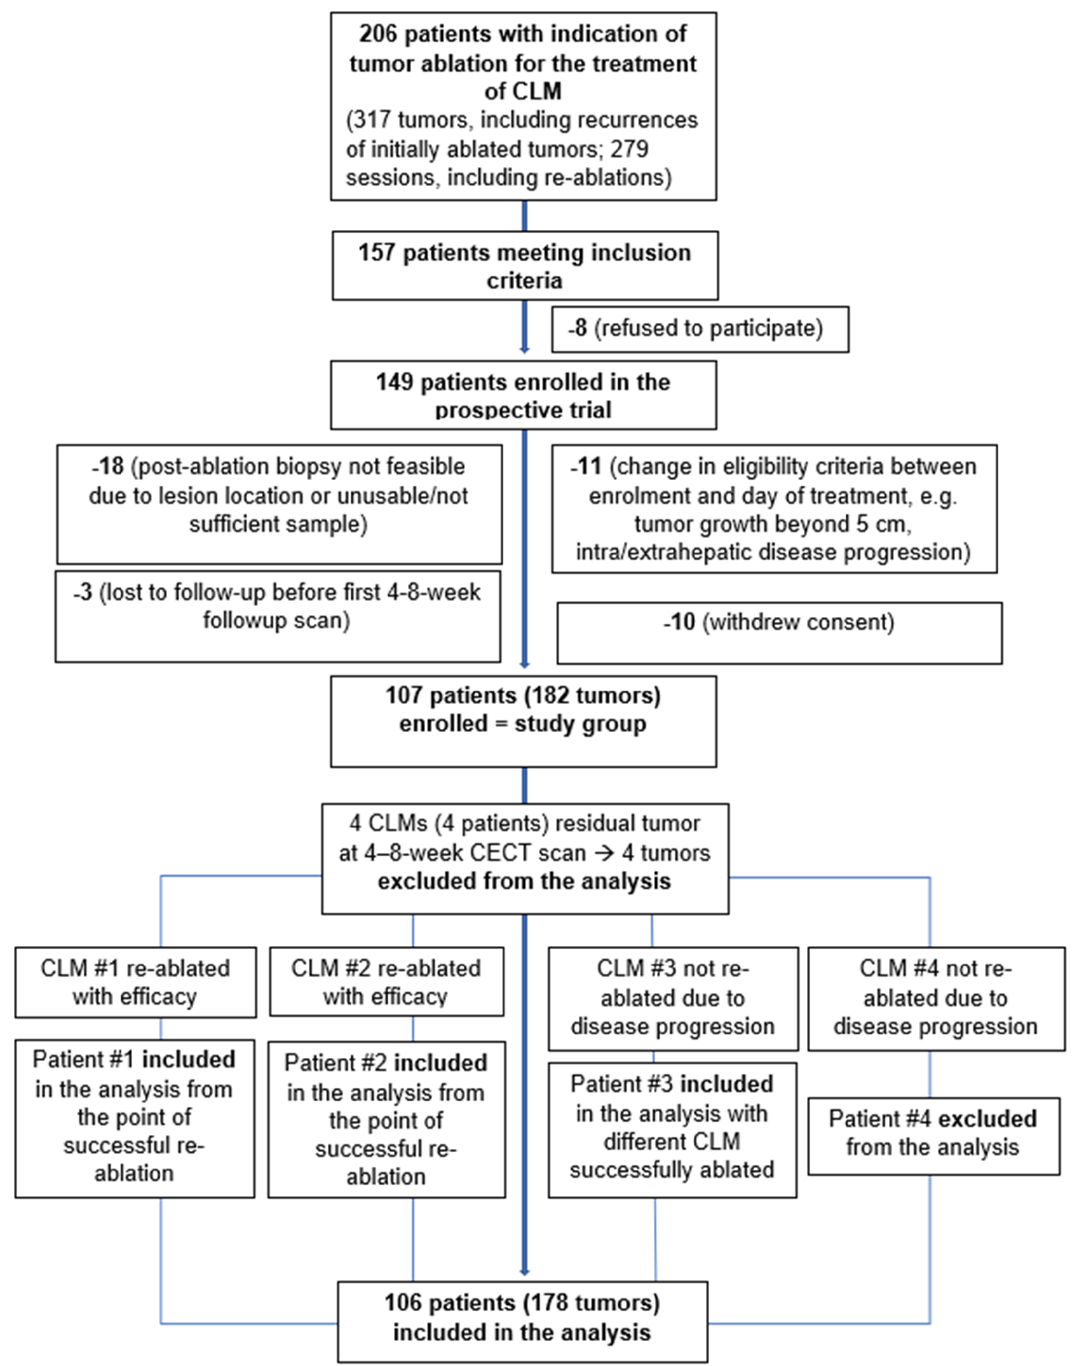
Figure 1. Application of inclusion/exclusion criteria for determining the study group.